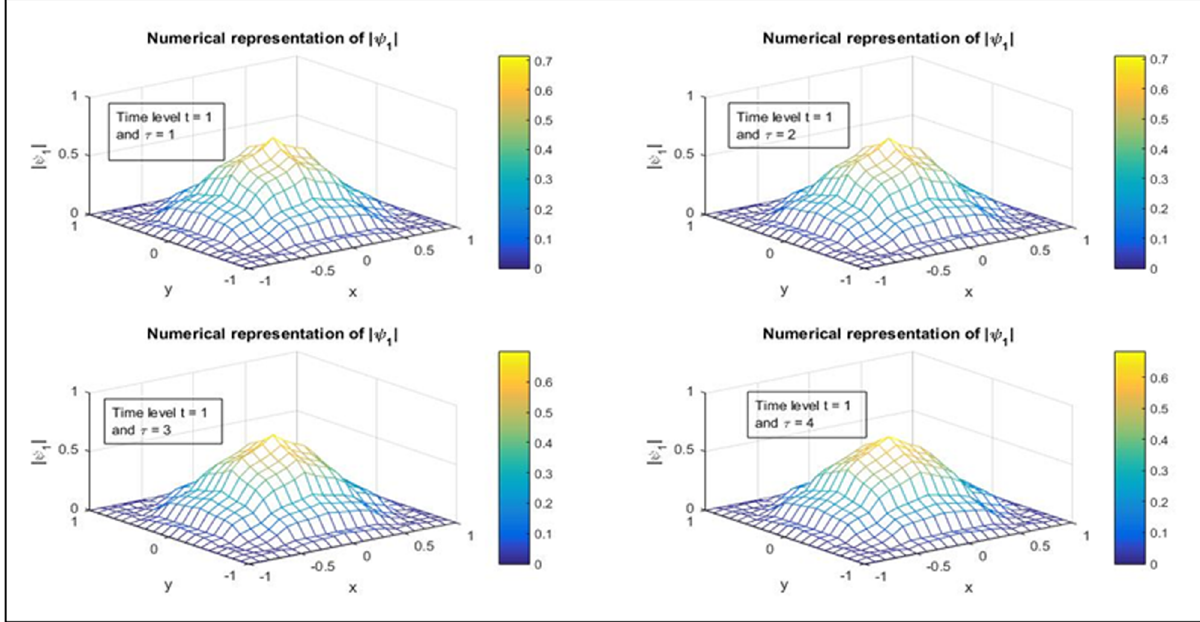
Figure 17: Graphical representation of numerical solution of fi rst - wave amplitude at = t 1 for parameters = N 21 , = t Δ 0.0001 , and = α 0.1 and for di ff erent values of tension parameter τ